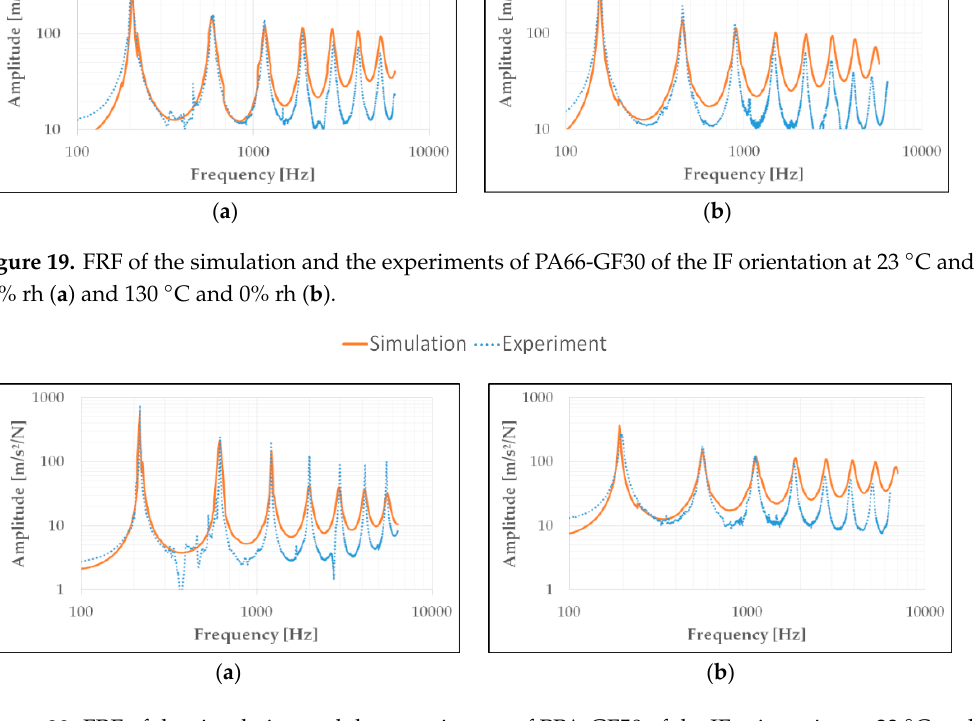
Figure 20. FRF of the simulation and the experiments of PPA ‐ GF50 of the IF orientation at 23 °C and 50% rh ( a ) and 130 °C and 0% rh ( b ).